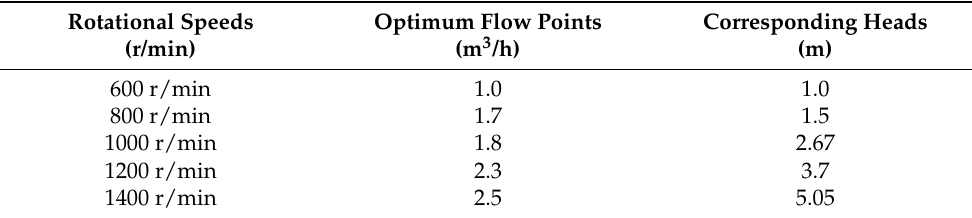
Table 2. Optimum flow rates and the corresponding heads for different rotational